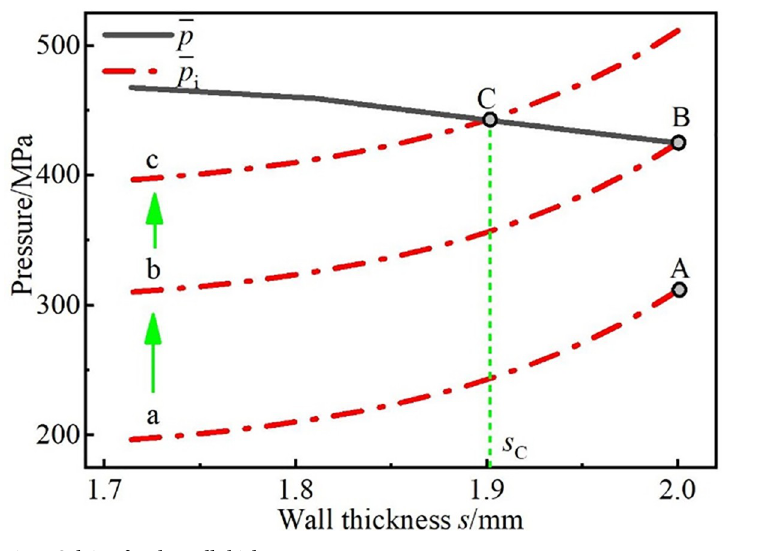
Fig 5. Solving for the wall